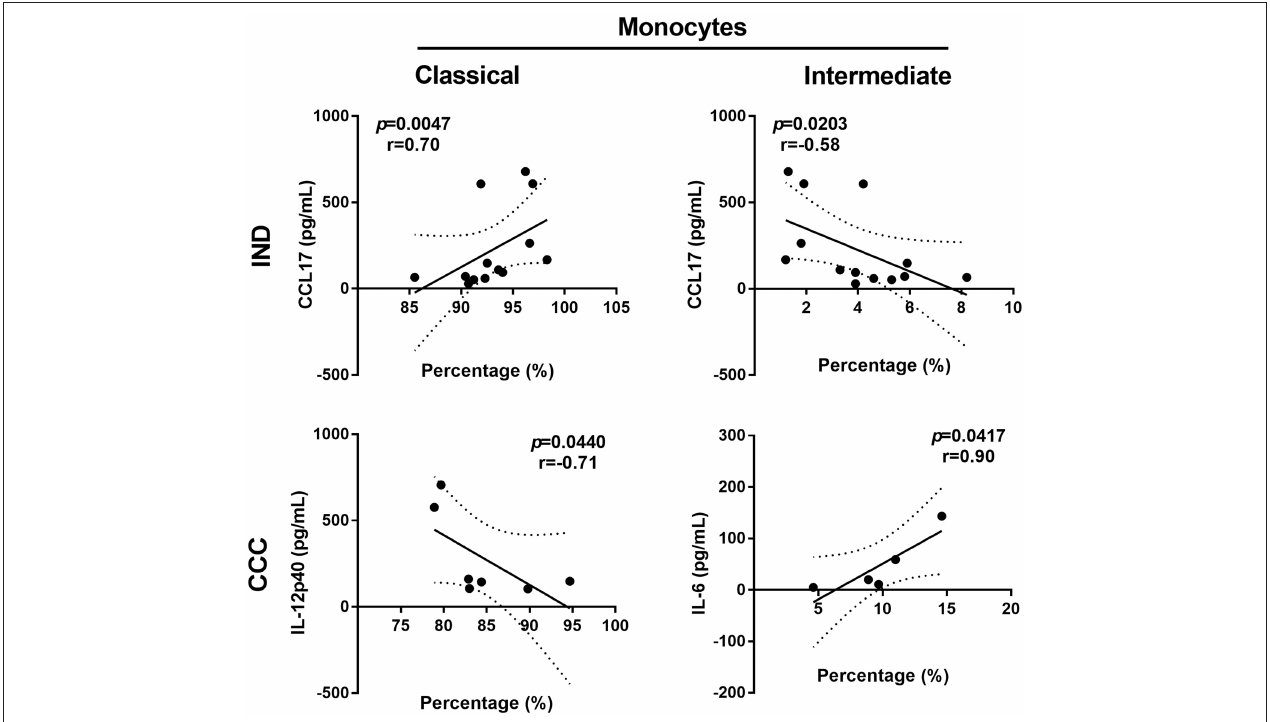
FIGURE 4 | Scatter plot showing the followings correlations: percentages of classical monocytes and CCL17 concentration in IND, percentages of intermediate monocytes and CCL17 concentration in IND, percentages of intermediate monocytes and IL-6 concentration in CCC. Spearman’s rank correlation coefficient ( r ) and p- values were calculated for every association using non-parametric Spearman’s correlation test. IND, indeterminate; CCC, chronic chagasic